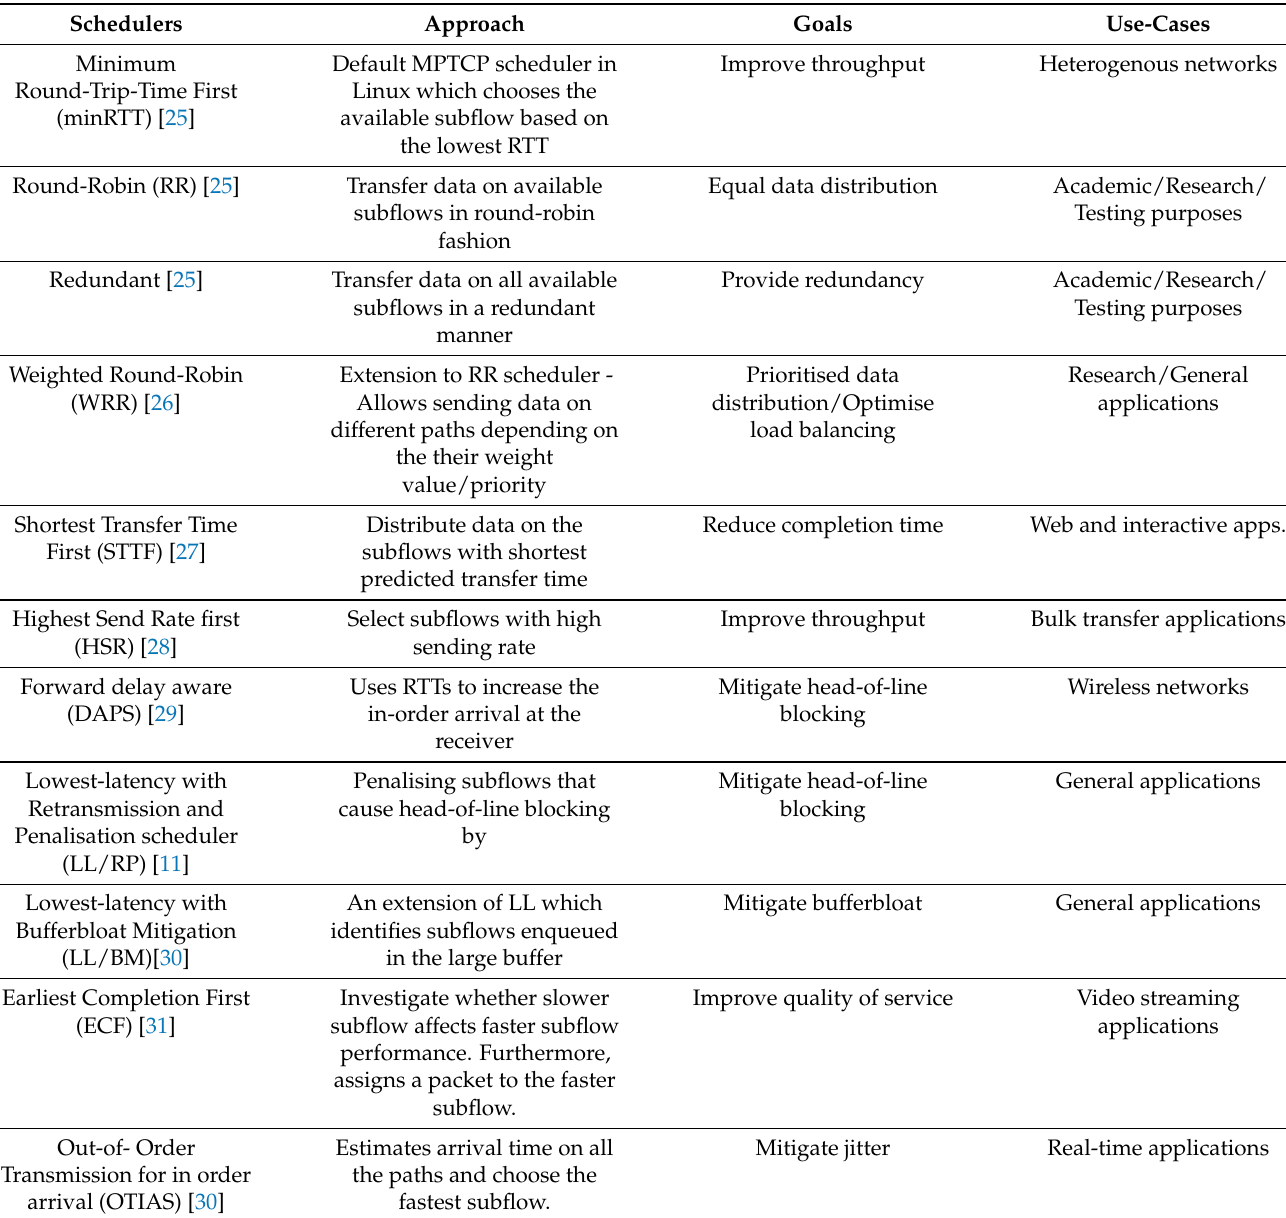
Table 1. Main MPTCP Scheduling Solutions in